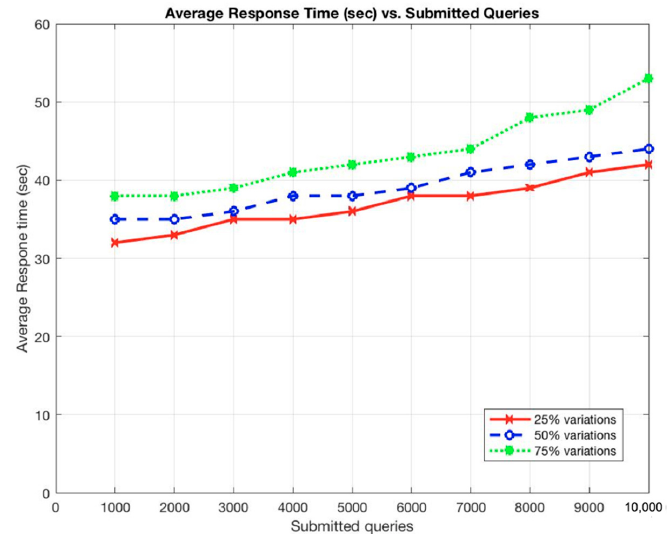
Figure 7. Average response time (s) vs. submitted queries.